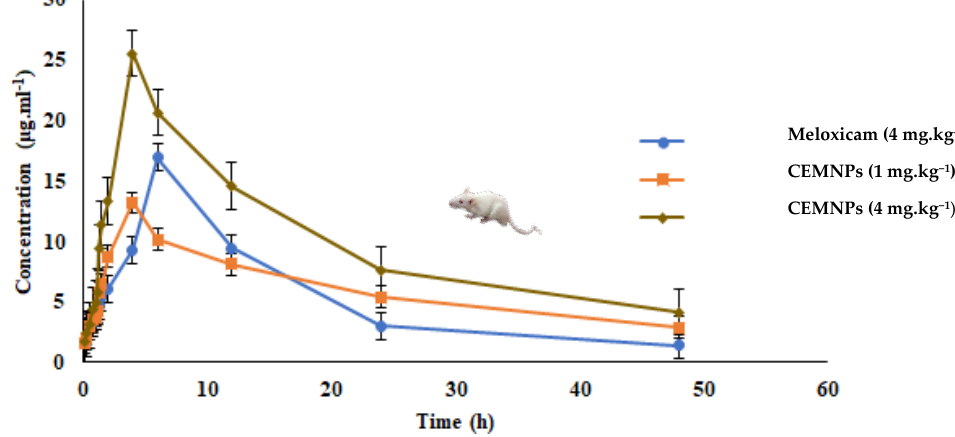
Figure 7. Mean (±SE) plasma concentration vs. time profile of meloxicam following single oral administration of meloxicam (4 mg·kg − 1 ) and high (4 mg·kg − 1 ) or low (1 mg·kg − 1 ) dose of chitosan- encapsulated meloxicam nanoparticles (CEMNPs) in male Wistar rats (n = 3 at each time interval).